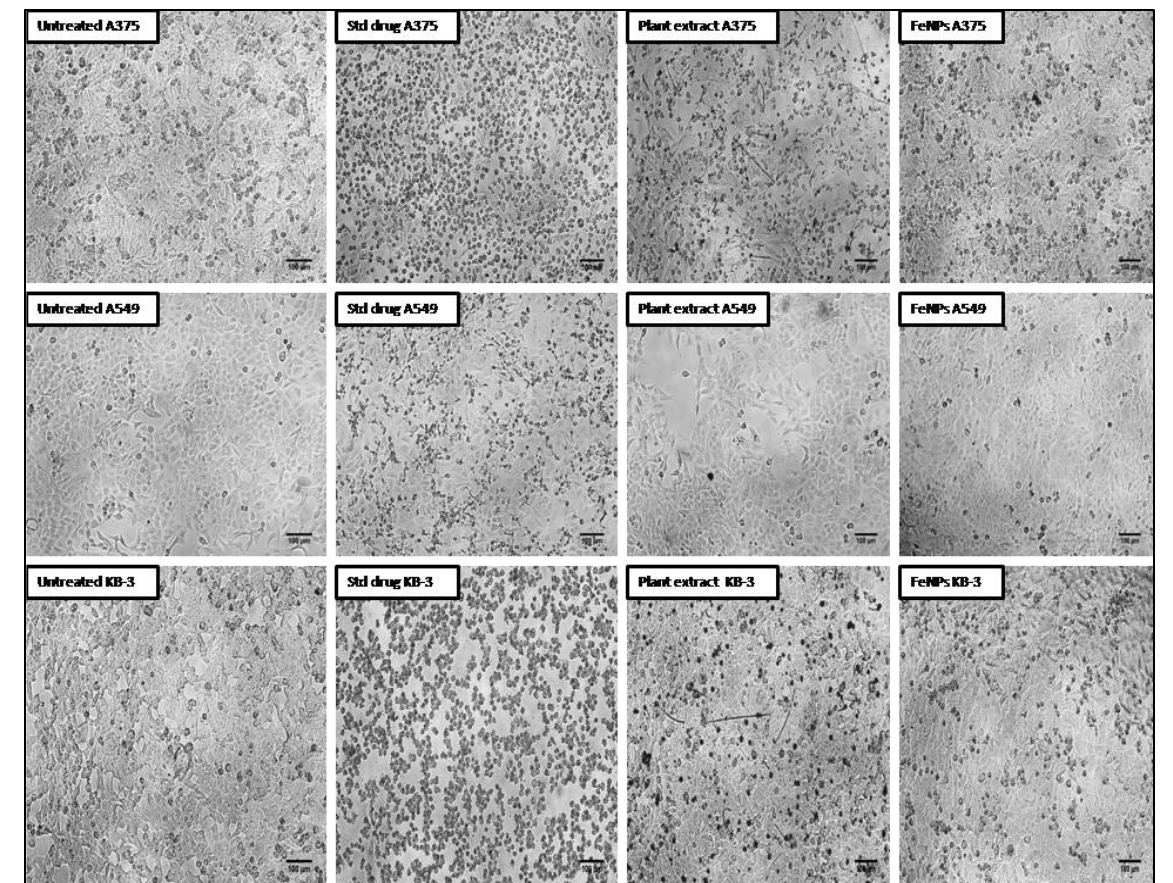
Figure 14. Percentage of cell viability for aqueous leaf extract of V. leucoxylon and its synthesized iron nanoparticles against different cancer cell lines.